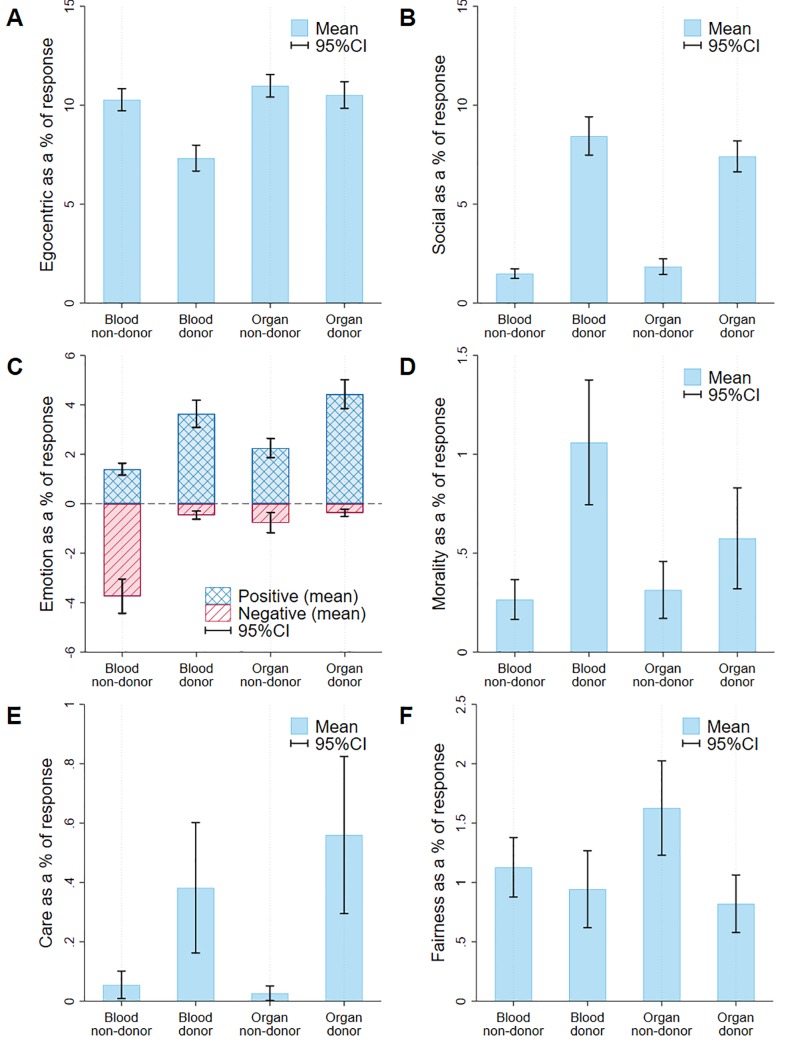
Percentage of words used in responses.